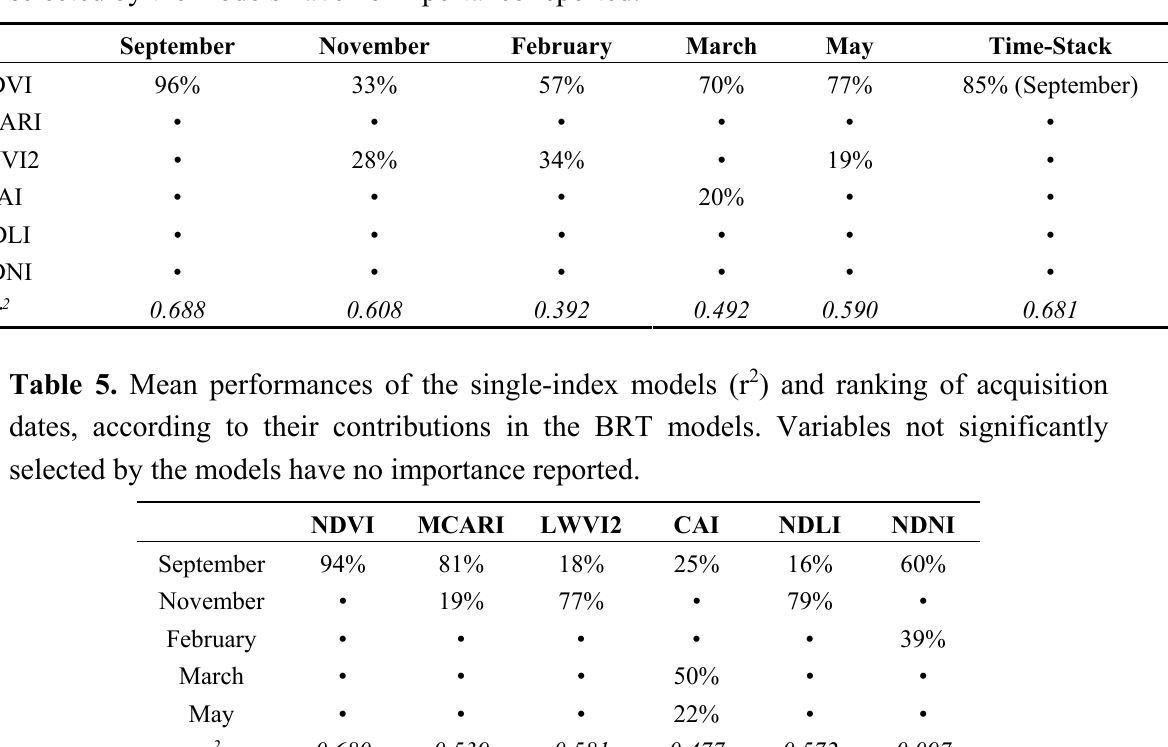
Table 4. Mean performances of the multi-index models (r 2 ) and importance of the spectral indices, according to their contributions in the BRT models. Variables not significantly selected by the models have no importance reported.